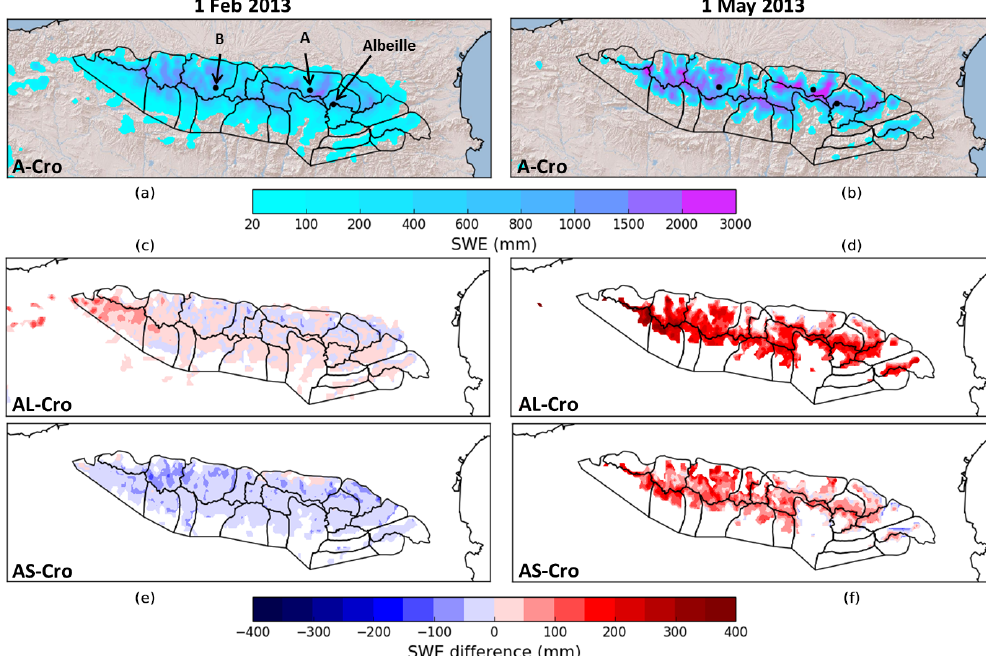
Figure 9. Snow water equivalent simulated by A-Cro (a, b) on 1 February 2013 (a, c, e) and 1 May 2013 (b, d, f) over the Pyrenees. Differences between the SWE simulated by AL-Cro (c, d) and AS-Cro (e, f) with A-Cro at the same dates. Points A and B and Albeille station are indicated by black